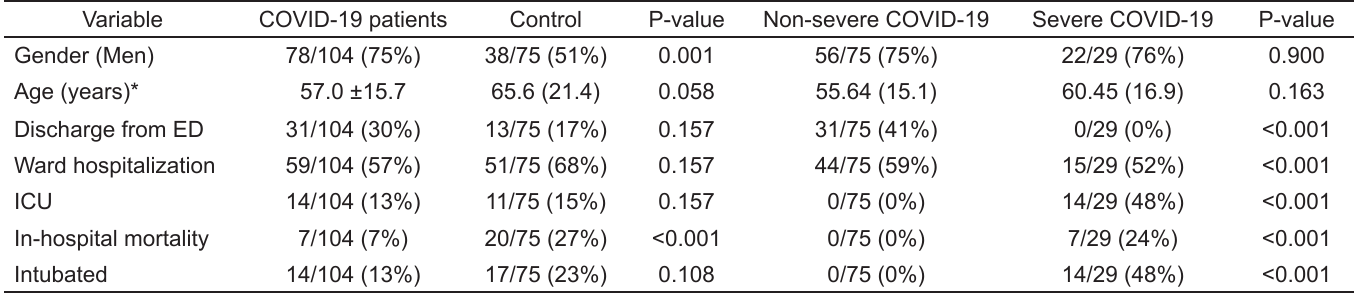
Unless otherwise specified, data are numbers of patients, with frequency in parentheses.